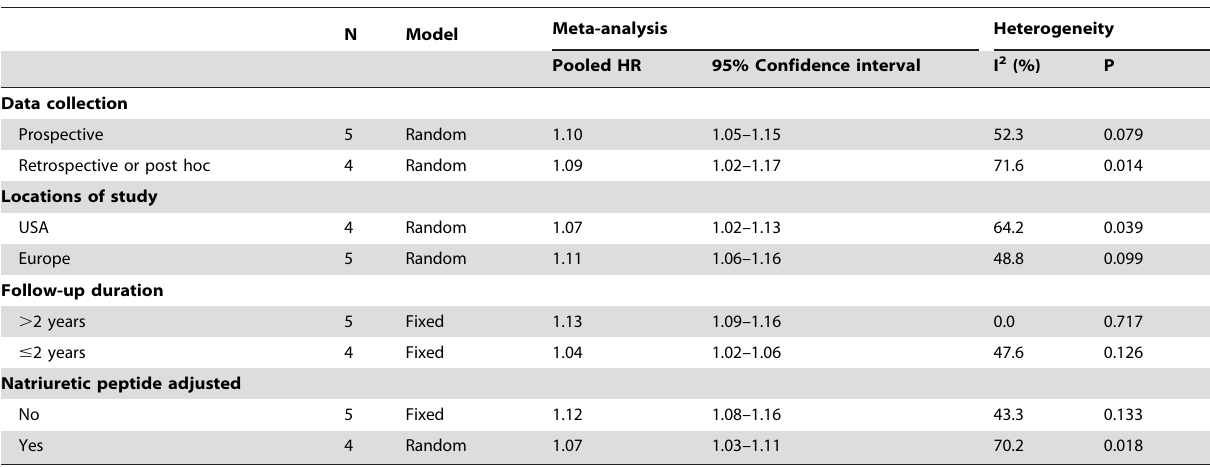
Table 3. Subgroup